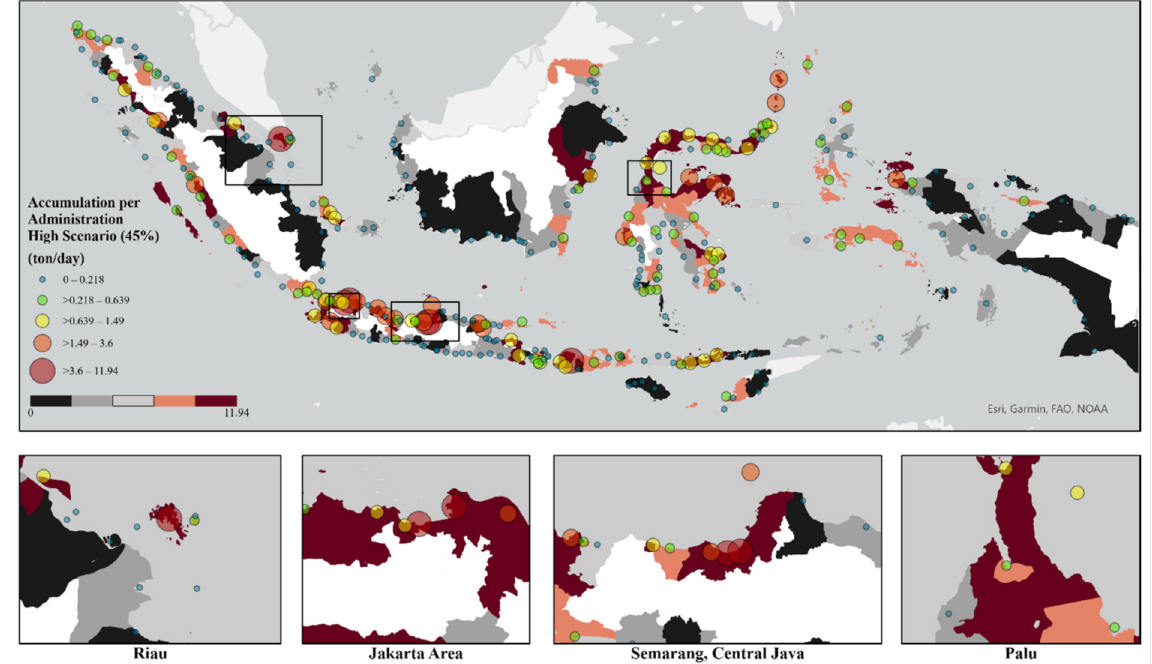
Figure 10. Accumulation of plastic waste from streamflow trough estuary per coastal regency based on scenario 3.